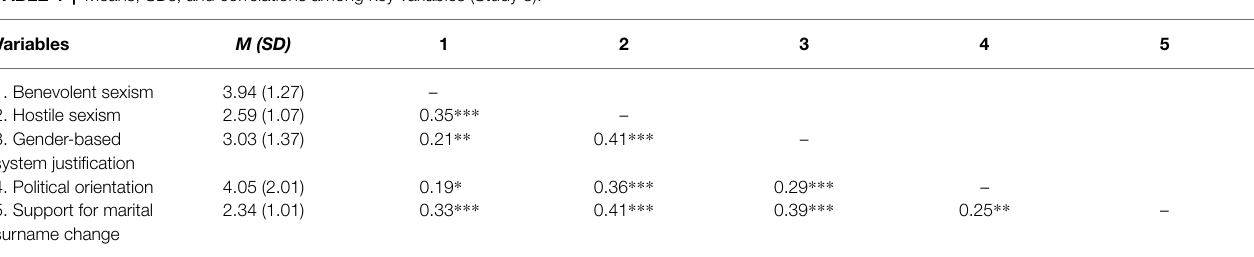
TABLE 4 | Means, SDs, and correlations among key variables (Study